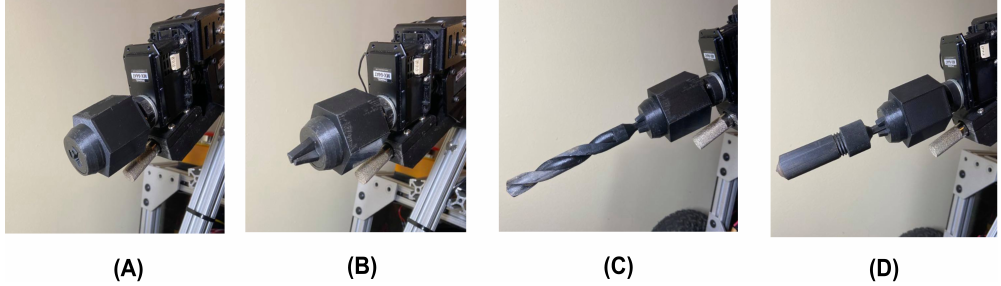
Figure 8. Multipurpose toolhead at the end of the manipulator. ( A ) Toolhead with jaws retracted; ( B ) Toolhead with jaws extended; ( C ) Toolhead with a soil drill bit; ( D ) Toolhead with a soil